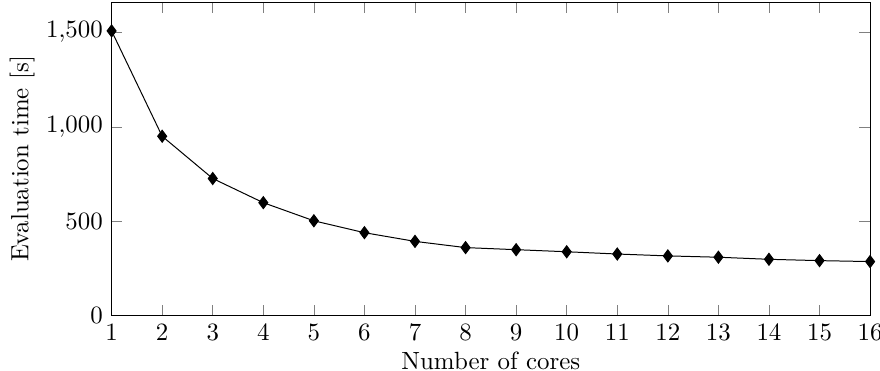
Figure 4: Multithreading performance for a single-round CRAFT design with four bit redundancy.